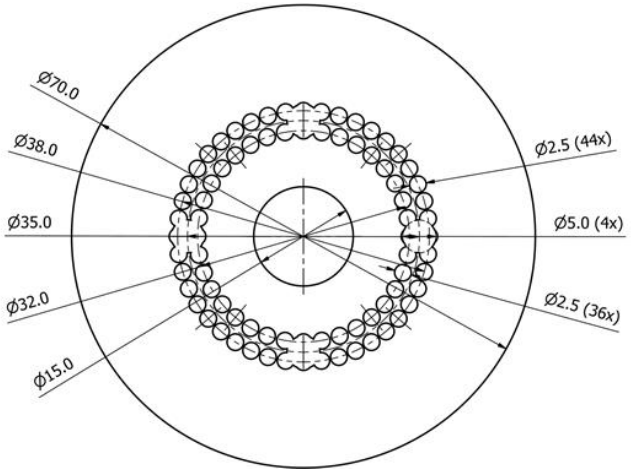
Figure 5. Newly developed design of double-clad optical fiber.